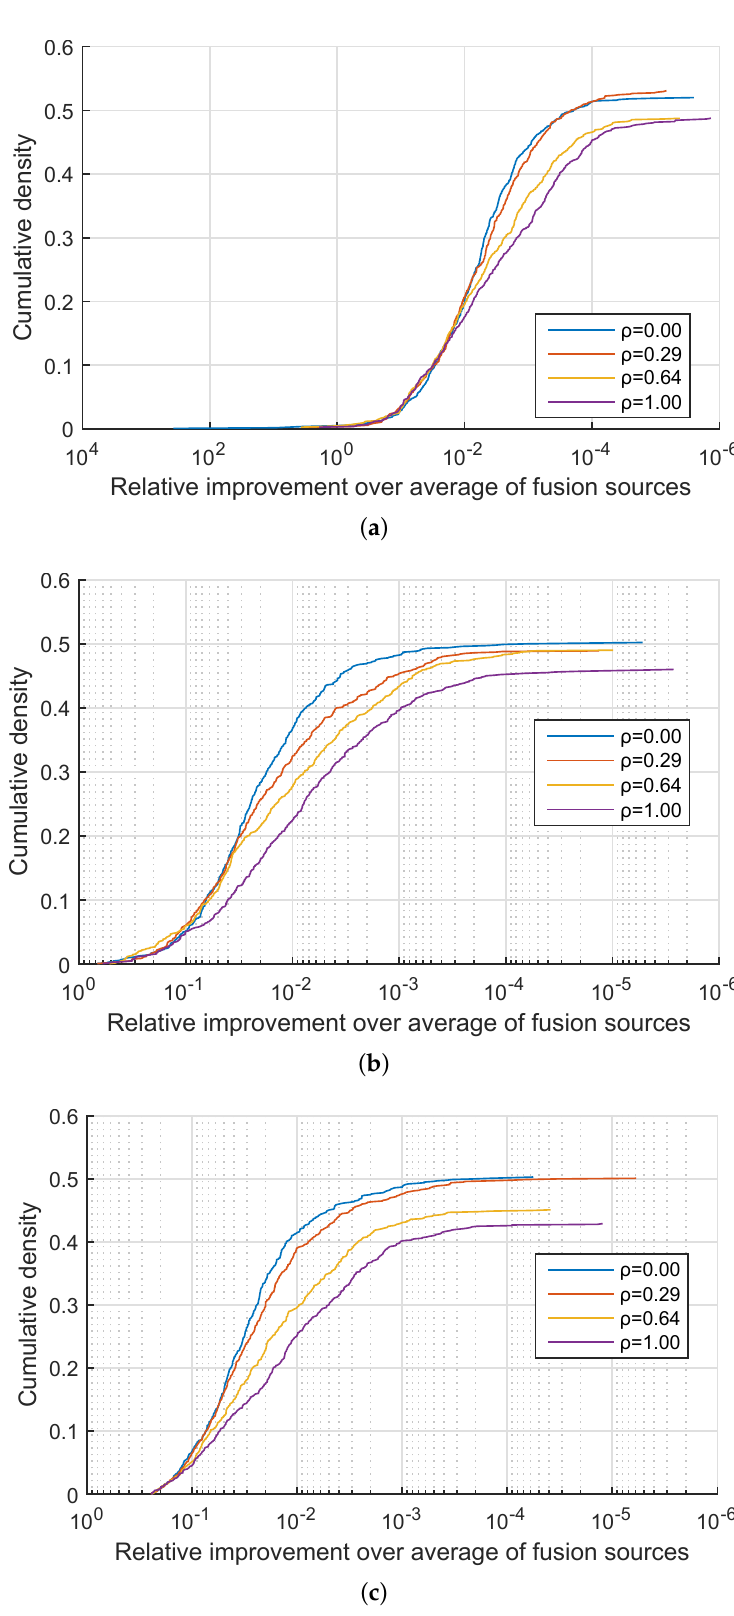
Figure 3. Synthetic data: relative improvement in the confidence of the correct information source identification of the proposed quadratic mean-based fusion over linear fusion, as the corresponding cumulative distribution function. ( a ) β n = 3.00, d = 0.10; ( b ) β n = 3.00, d = 2.28; ( c ) β n = 3.00, d =